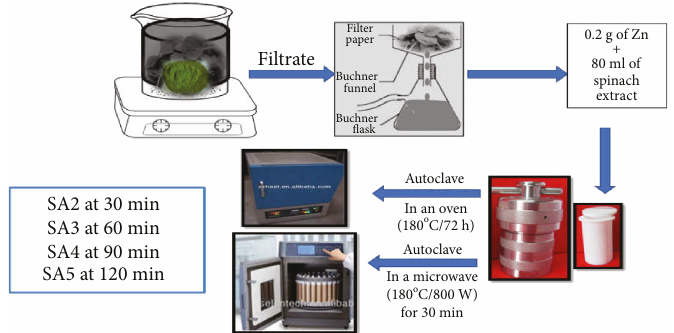
Scheme 1: Preparation equipment of ZnO catalyst both with conventional heating technique and microwave-assisted